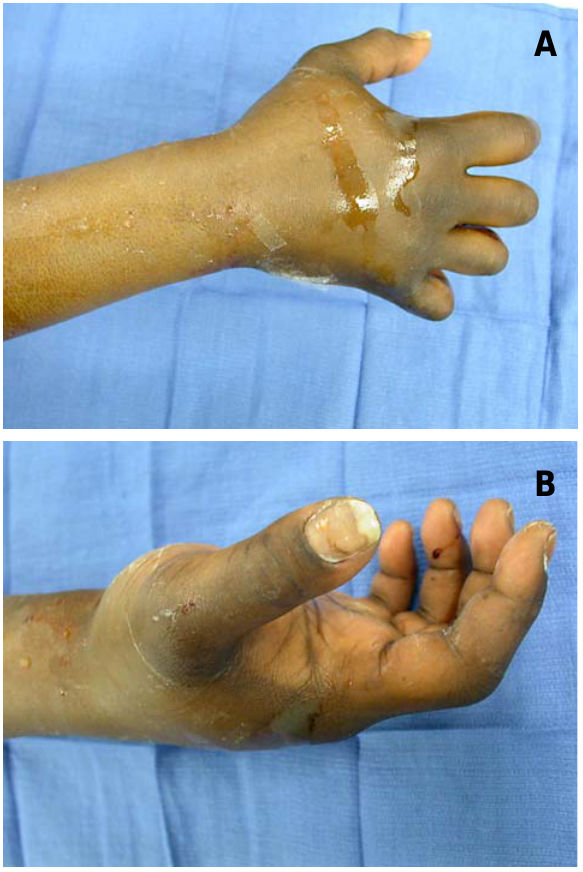
Figure 2A and B – Elevated forearm compartment pressures lead to this typical flexed